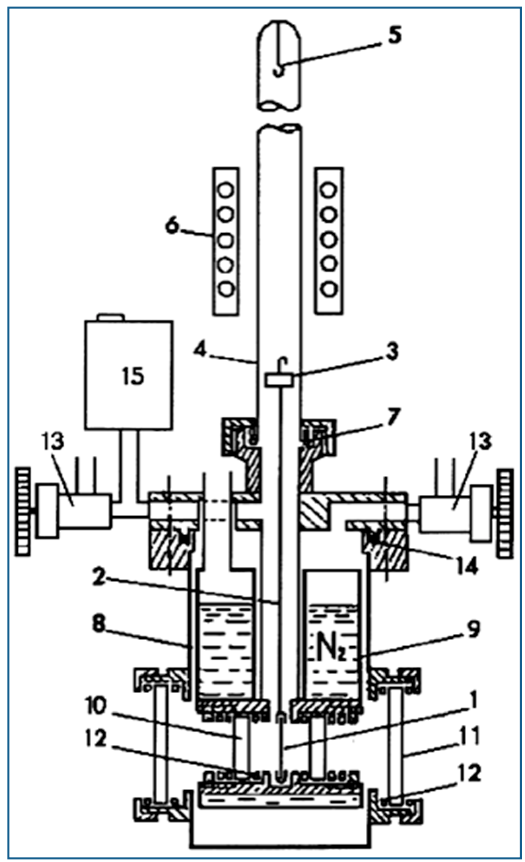
Figure 1. Scheme of the homemade (stainless-steel) variable-temperature IR cell: (1) sample wafer, (2) sample holder, (3) magnetically driven anchoring piece, (4) quartz tube, (5) hook for fixing the sample wafer inside the furnace, (6) furnace, (7) Viton O-ring, (8) cell body, (9) refrigerated region, (10) and (11) optical windows, (12) indium gaskets, (13) valve, (14) Teflon gasket, (15) pressure gauge. Refs.